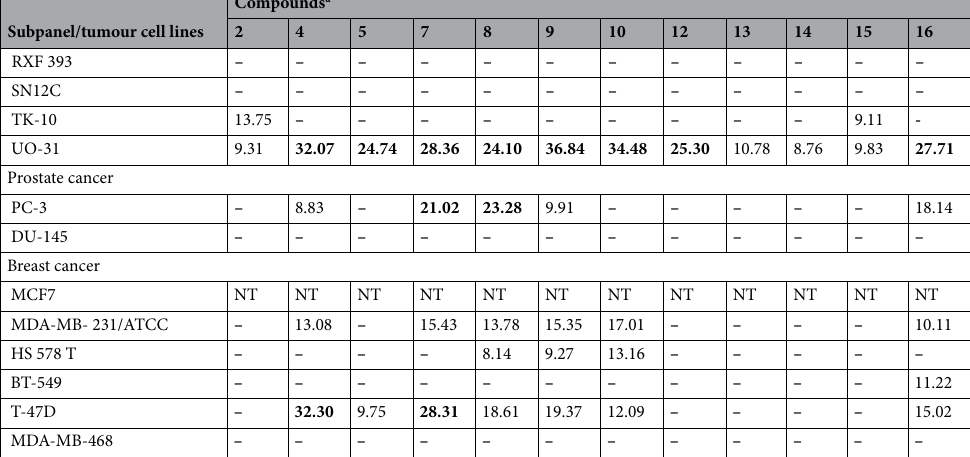
eters of drug candidates are evaluated during the primary screening stage because some drug candidates do not act therapeutically due to insufficient pharmacokinetic characteristics. This process may result in better hits